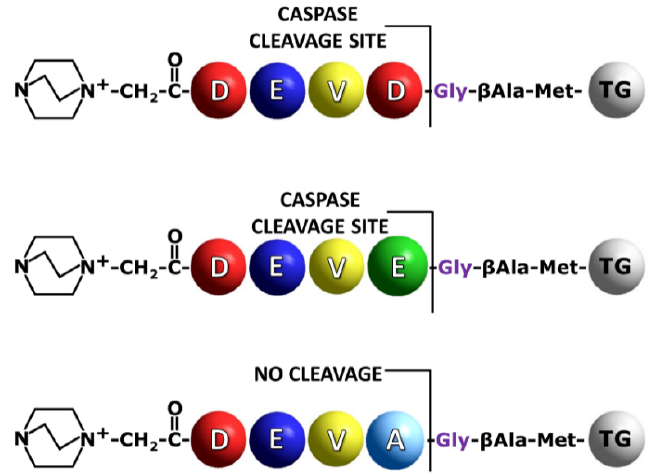
Figure 2. Schematic presentation of the synthesized model sequences containing QA group for the on-bead analysis of peptide bond hydrolysis by caspases. TG indicates TentaGel resin bead.